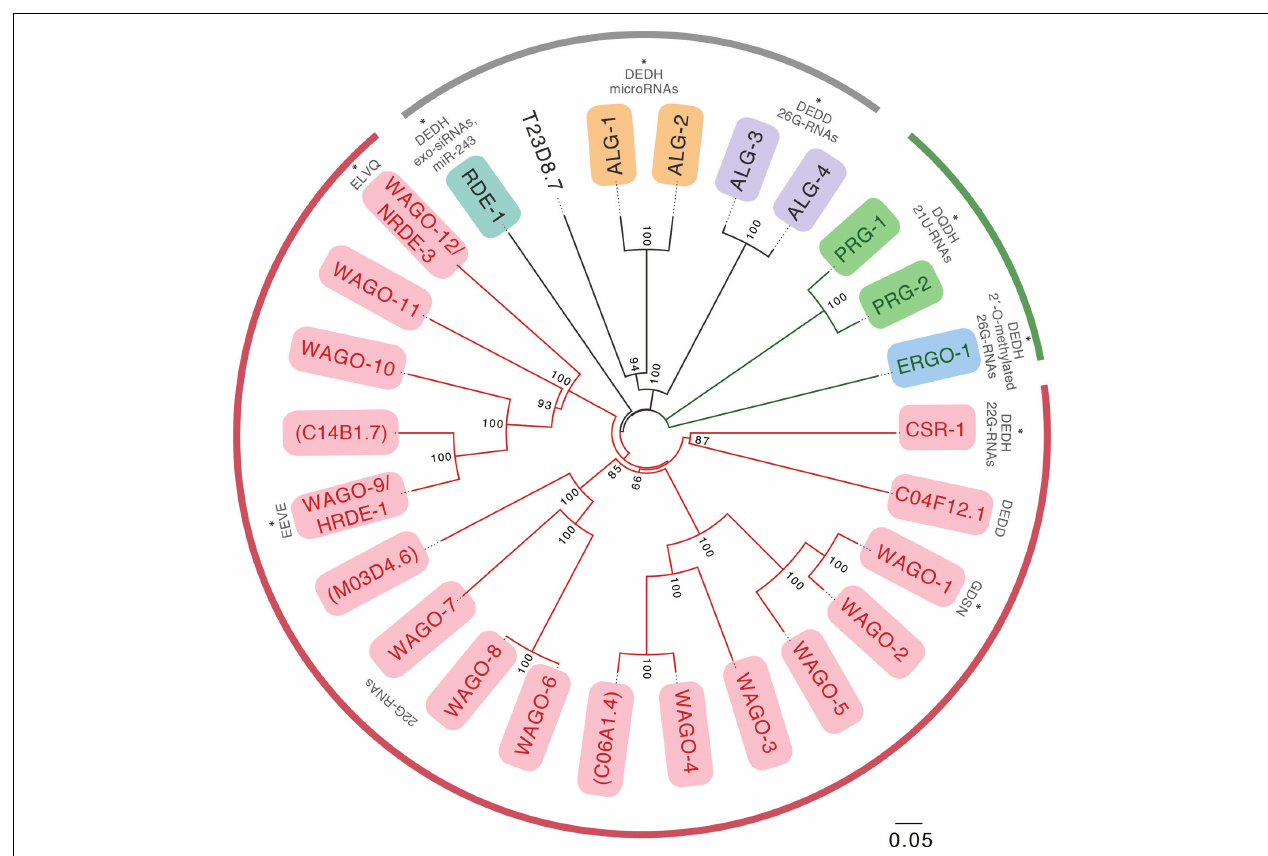
of the AGOs previously examined and for those additional AGOs possessing a putative functional catalytic site (i.e., C04F12.1). Full-length protein sequences were obtained fromWormbase.org. Multiple sequence alignment was generated usingT-coffee and bootstrapping was conducted using ClustalX. Numbers on the branches report the level of confidence by bootstrap analysis (1000 bootstrap replicates). Bootstrap values < 70% were excluded from the